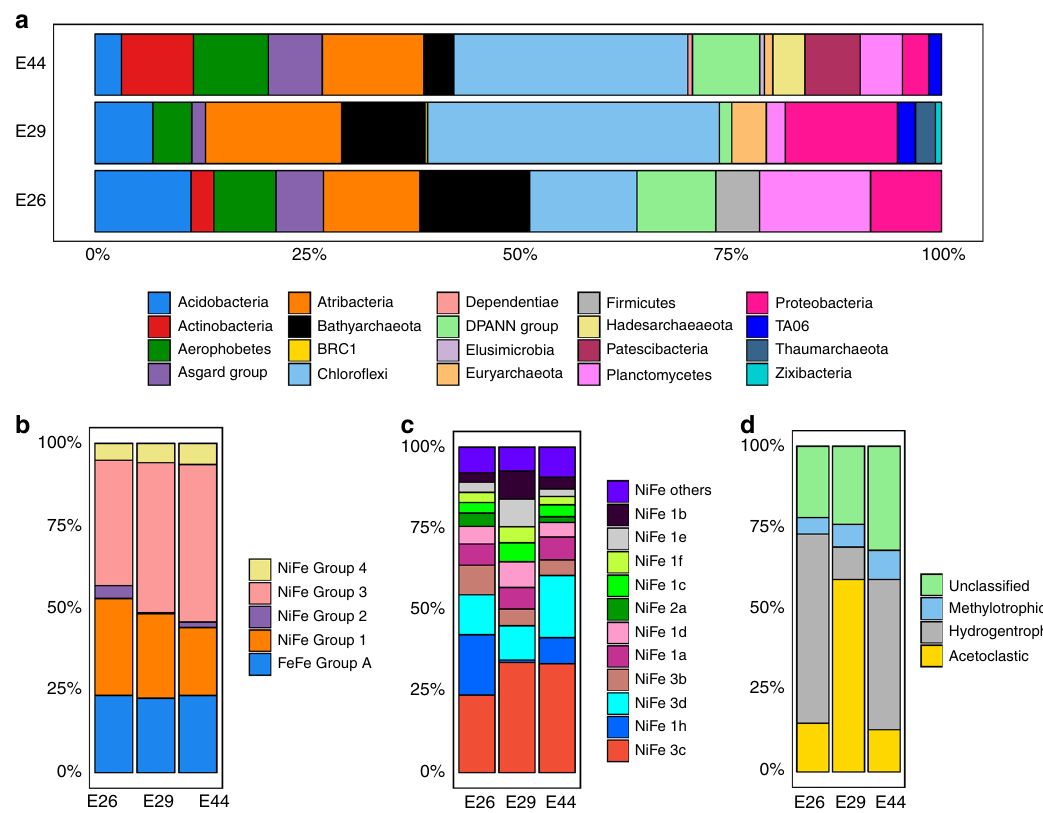
Fig. 1 Relative frequency of metagenomic reads for different marker genes at Sites E26, E29, and E44. a Community composition based on reconstruction of full-length 16S rRNA genes from the metagenomes. Eukaryotes and unassigned reads are not shown. b Relative occurrences of hydrogenases with different metal cofactors. c Relative abundance of different subtypes of NiFe hydrogenases. d Relative abundance of mcrA genes indicative of different types of